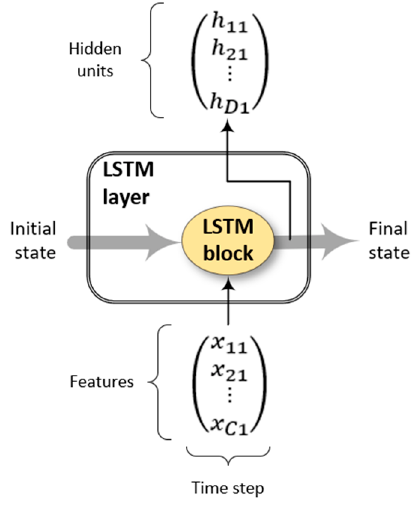
Figure 14. Structure of LSTM layer.